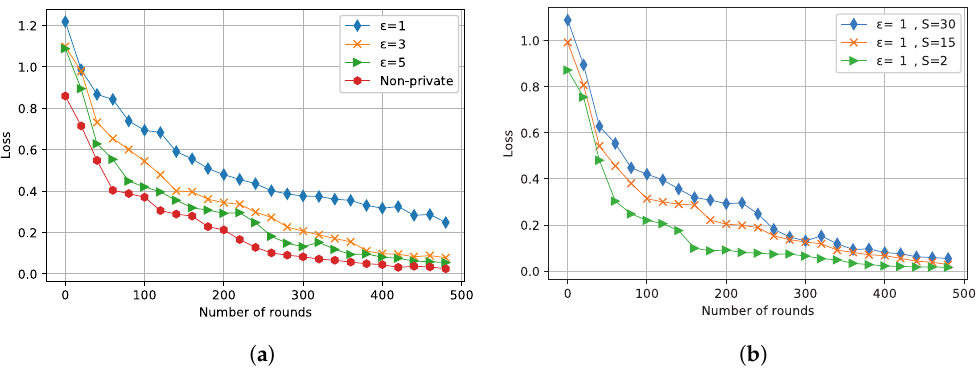
Figure 4. ( a ) The impact of the privacy-budget parameter on the model. ( b ) The impact of the number of participants on the model.